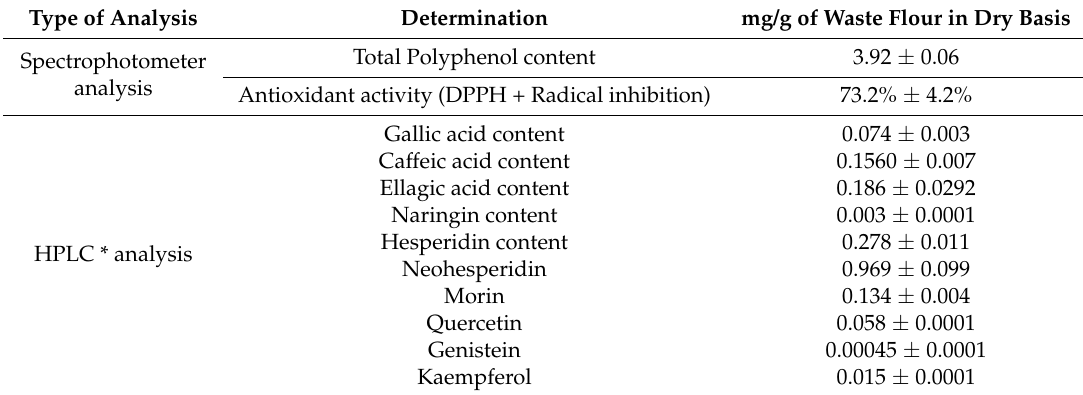
Table 2. Total polyphenol content, antioxidant activity, polyphenol identification, and concentration determination from citrus waste flour